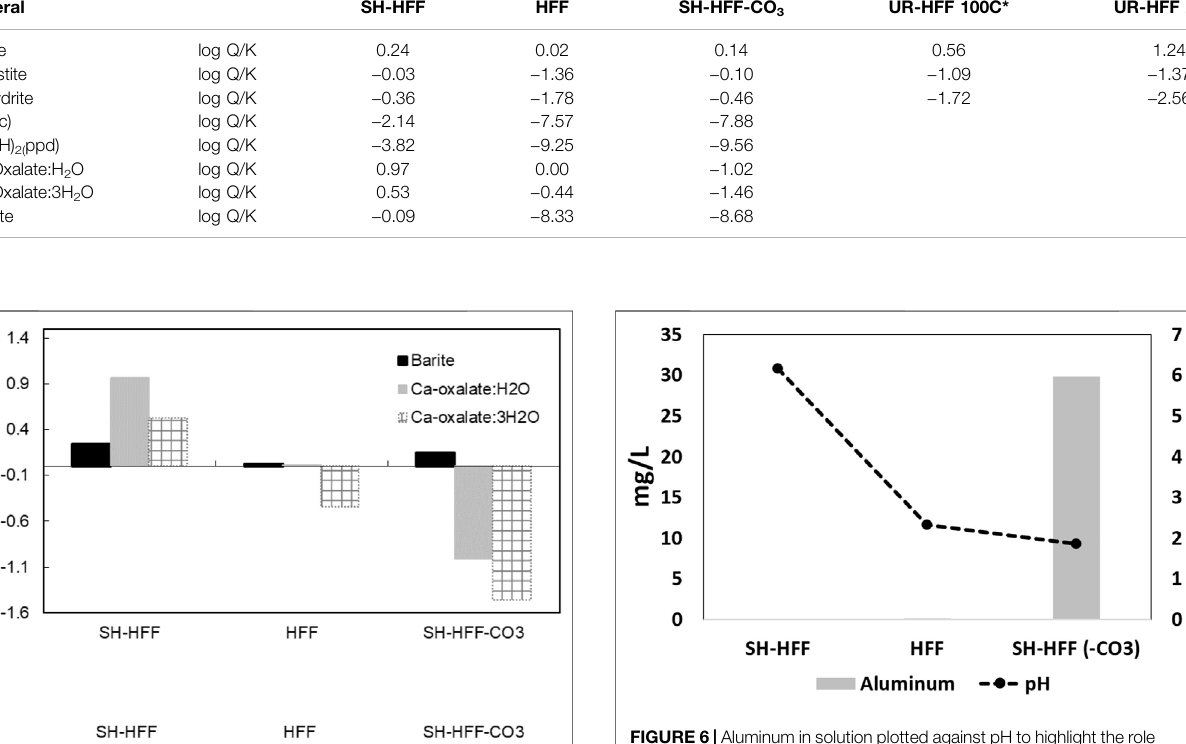
TABLE 5 | Saturation indices (SI) of selected minerals. Ca-oxalates and calcite SI were calculated using MINTEQ database and other minerals were calculated using Pitzer database. The temperature of experimental groups is 100 ° C. *-UR-HFF values are determined using data from (Pilewski et al., 2019). Mineral